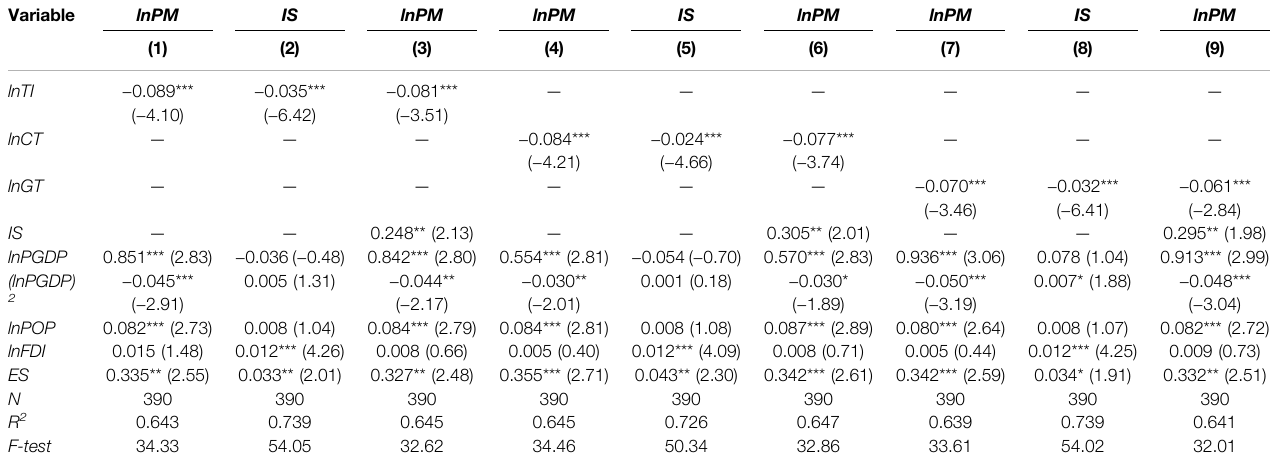
TABLE 9 | Mediating effect of industrial structure.